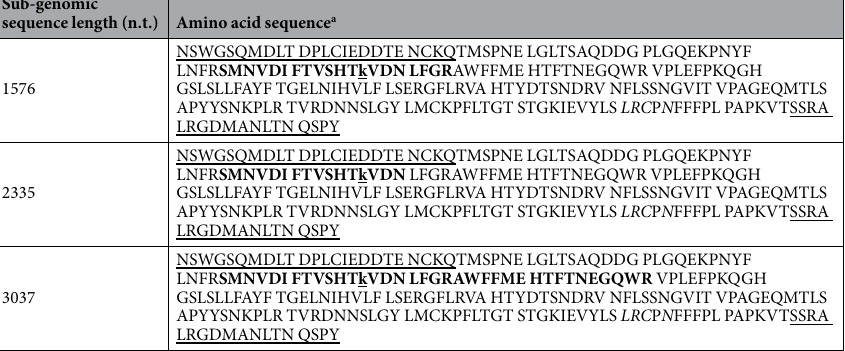
Table 2. Summary of peptides derived from capsid protein VP1 that were crosslinked to sub-genomic HPeV1 RNA. a The RCAP peptides identified are in bold. The missed cleavages are shown in lowercase and highlighted in bold-underline. The disordered regions not identified in the atomic model are underlined. Residues hypothesized to contact viral RNA in the atomic model highlighted in